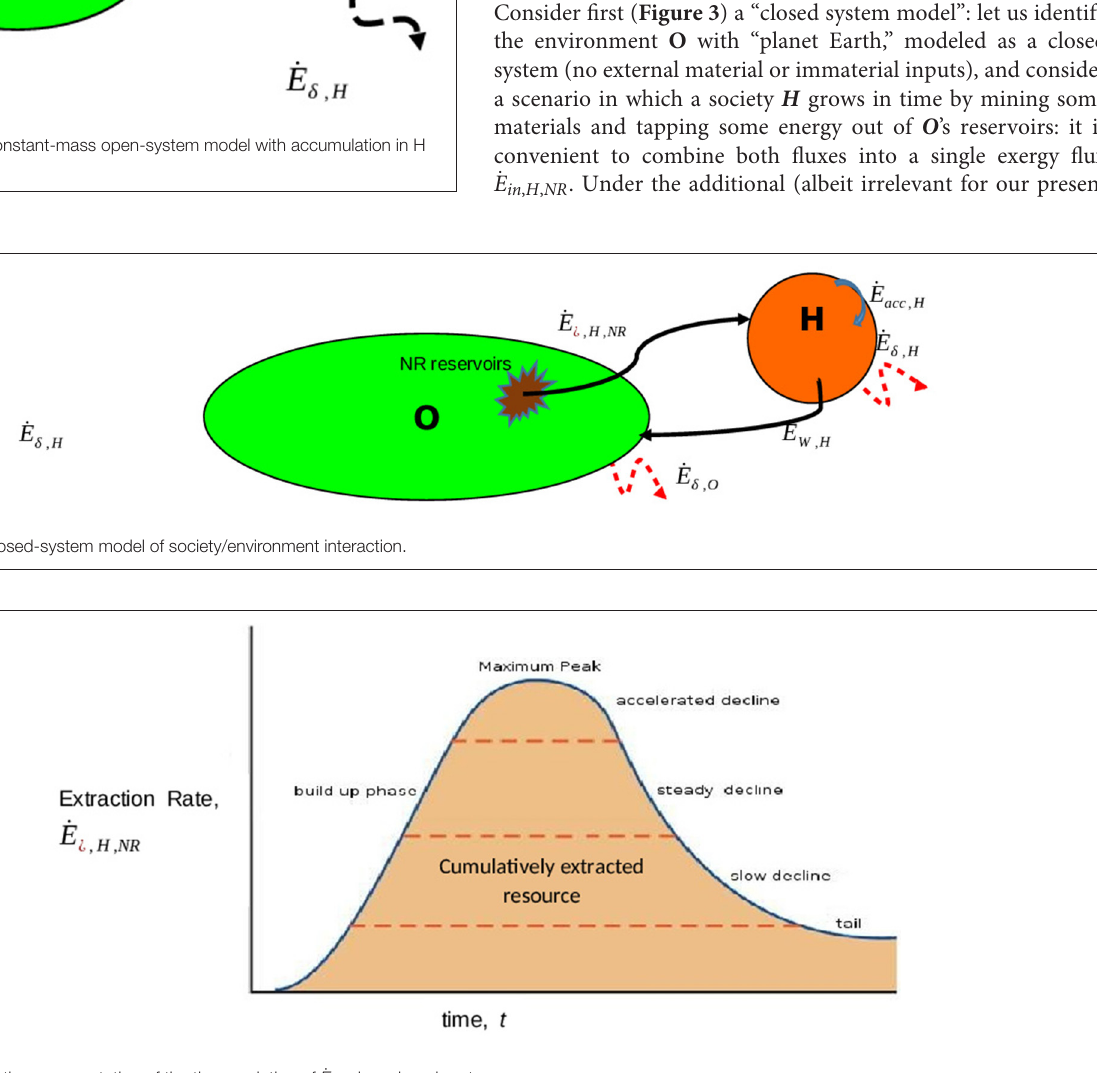
Frontiers in Sustainability |